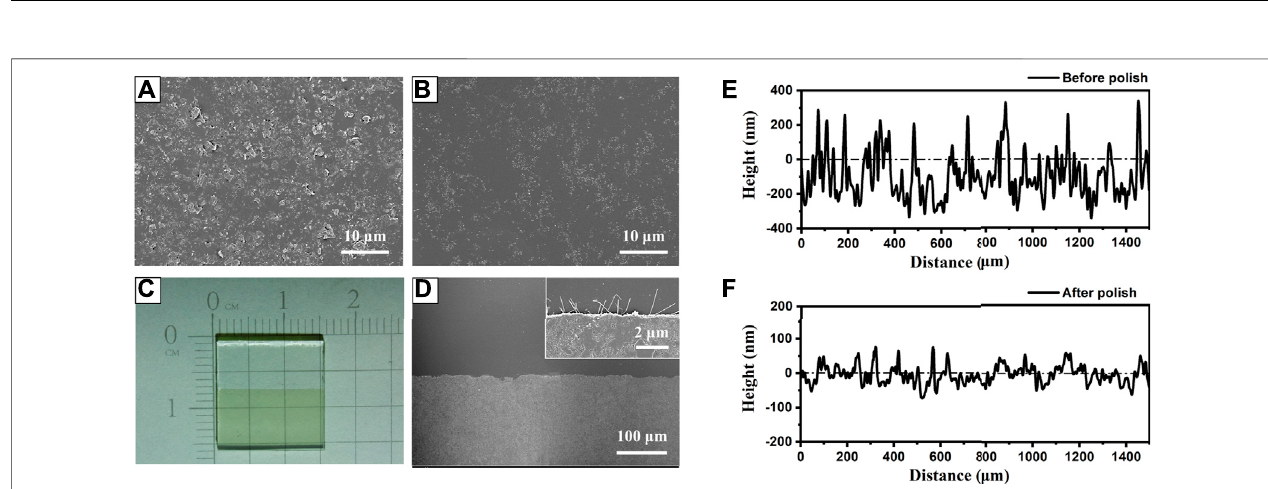
FIGURE 6 | Polishing and etching treatments of AgNWs/ZnO fi lms. SEM micrograph of AgNWs/ZnO fi lms (A) before and (B) after polishing; (C) photograph of patterned AgNWs/ZnO fi lms and (D) top view of the etched edge. Surface topography of AgNWs/ZnO fi lms (E) before and (F) after polishing.